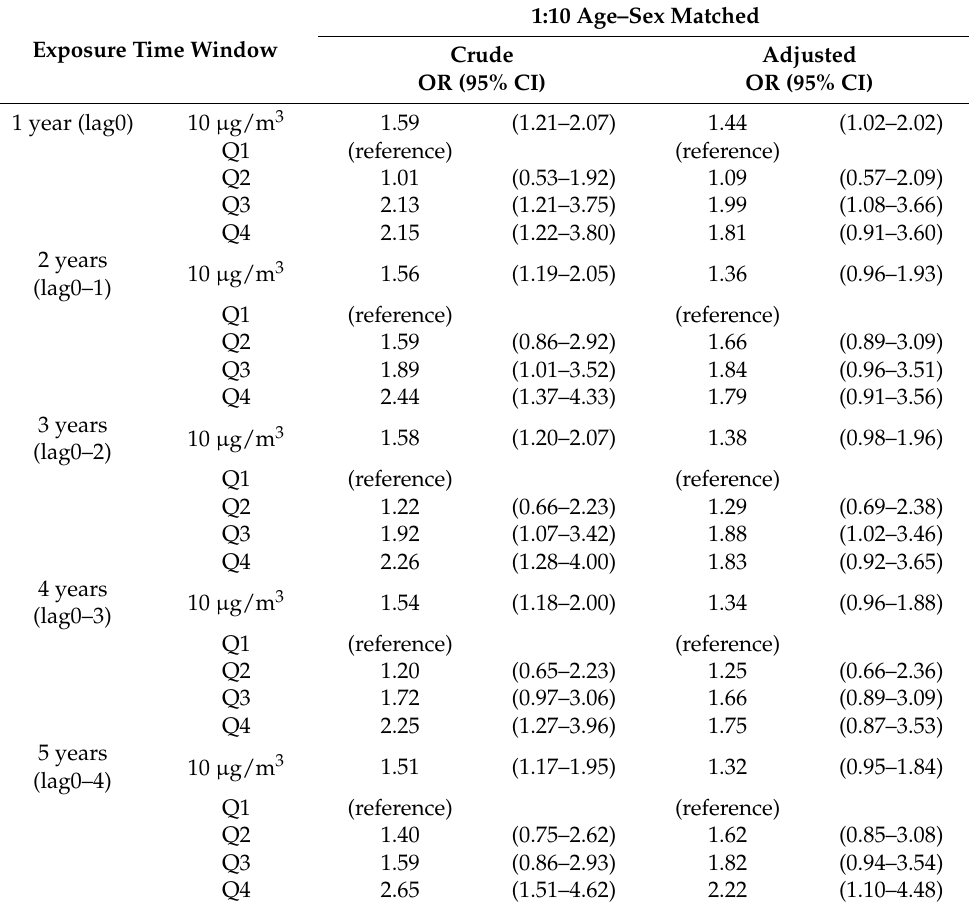
Table 2. Association between a 10 µ g/m 3 increase in PM 10 concentration and ADHD according to the exposure time window of KNHANES 2008–2018 (n =